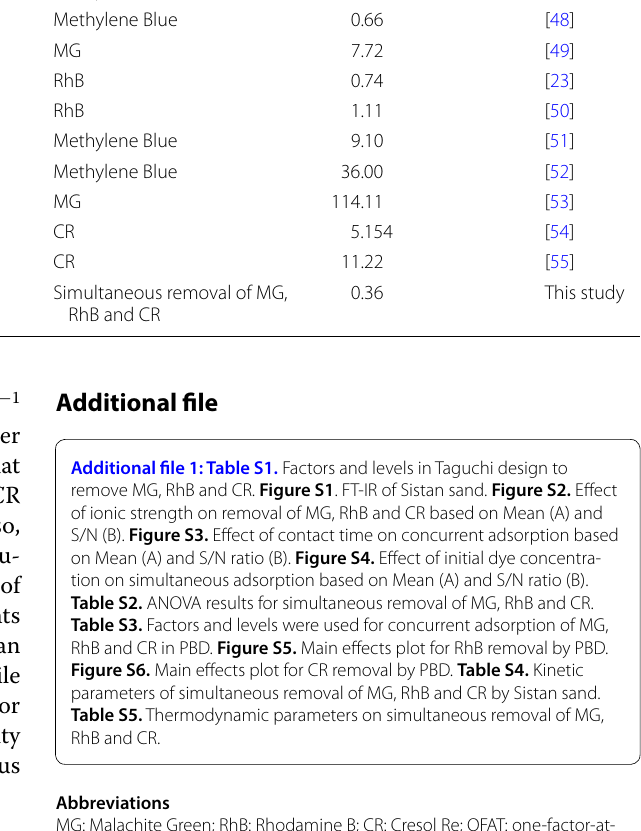
Table S2. ANOVA results for simultaneous removal of MG, RhB and CR. Table S3. Factors and levels were used for concurrent adsorption of MG, RhB and CR in PBD. Figure S5. Main effects plot for RhB removal by PBD. Figure S6. Main effects plot for CR removal by PBD. Table S4. Kinetic parameters of simultaneous removal of MG, RhB and CR by Sistan sand. Table S5. Thermodynamic parameters on simultaneous removal of MG, RhB and CR.